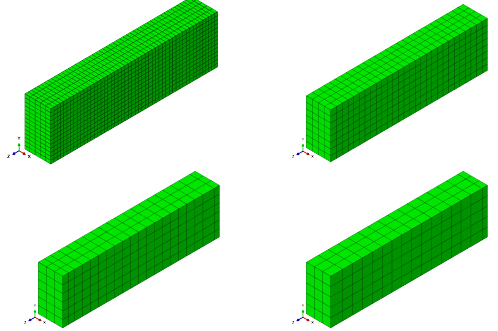
Figure 22. Meshes assumed in CS3 and